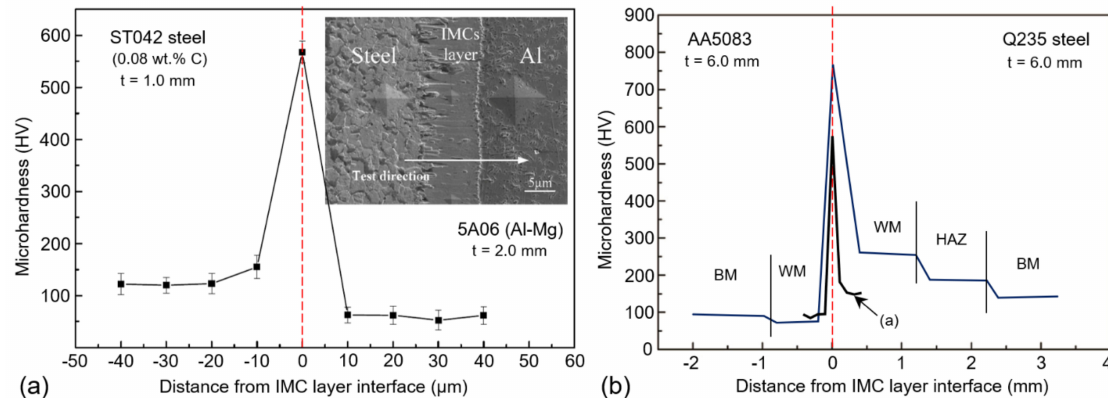
Figure 13. Hardness distribution and hardness spike at IMC layer along Fe–Al interface ( a ) in arc-assisted laser-brazing in thin plates [7]; and ( b ) laser keyhole welding of 6 mm thick plates; results from ( a ) was integrated, indicated by arrow [80].